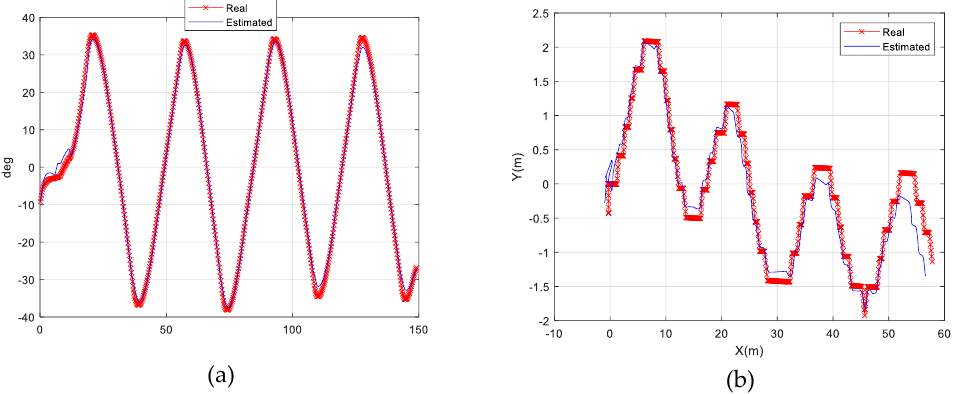
Figure 4. Trial #1 — Zig-Zag 30 – 30. ( a ) Heading angle estimation; ( b ) trajectory prediction.